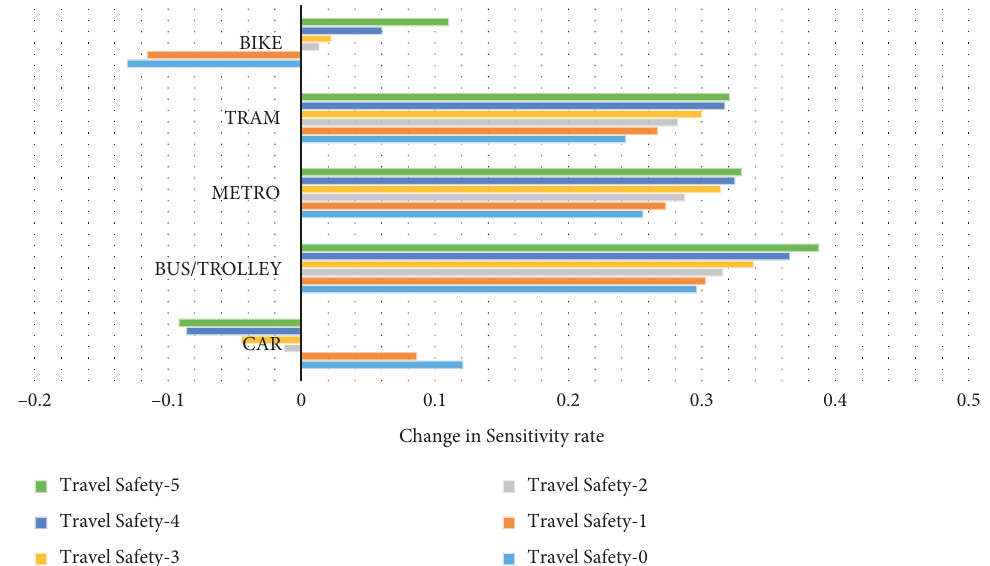
Figure 9: The values of the coefficients based on the changes in travel safety.